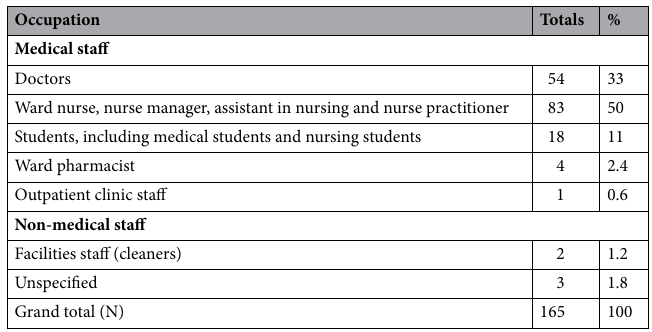
Table 1. Total count of participant